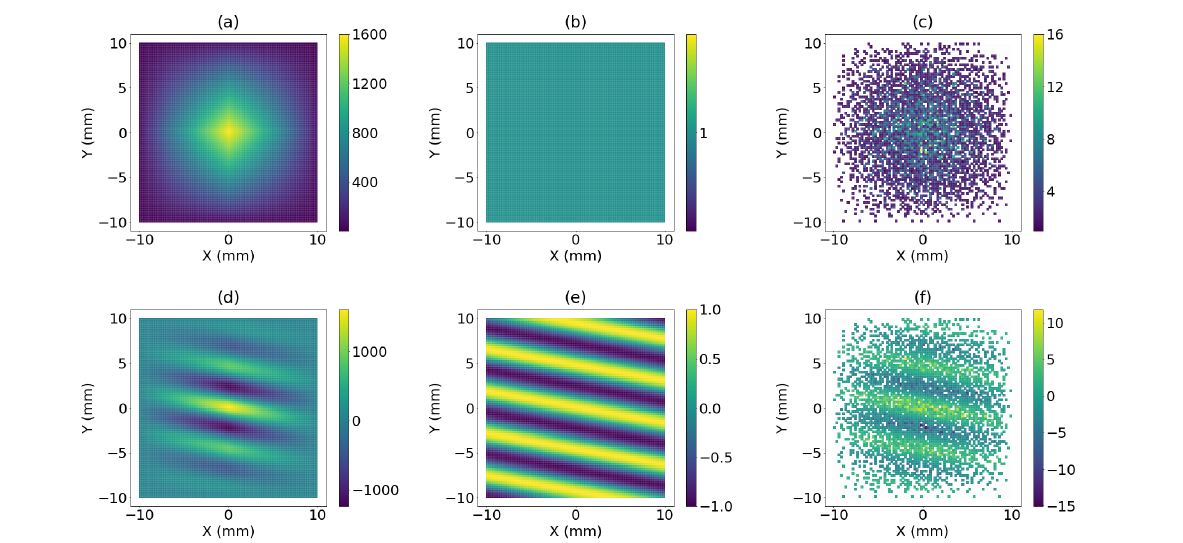
Figure 2. Projection of the FMC ( (cid:126) χ ) when the reflector is located at ( R = 100 mm, θ = 0 ◦ , φ = 0 ◦ ). If (cid:126) χ = ( R = 100 mm, θ = 0 ◦ , φ = 0 ◦ ) is in the reflector: ( a ) coarray of a full array; ( b ) coarray of minimum redundancy array; ( c ) coarray of sparse array. If (cid:126) χ = ( R = 100 mm, θ = 12 ◦ , φ = 80 ◦ ) is out of the reflector: ( d ) coarray of a full array; ( e ) coarray of minimum redundancy array; ( f ) coarray of sparse